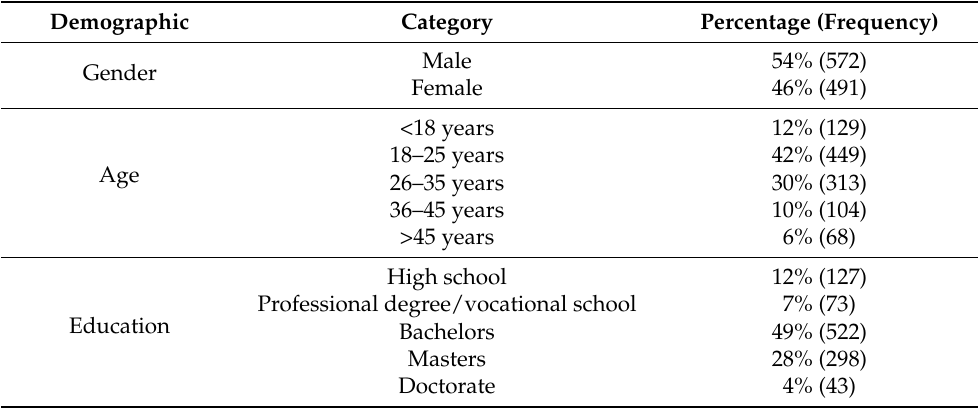
Table 1. Demographic